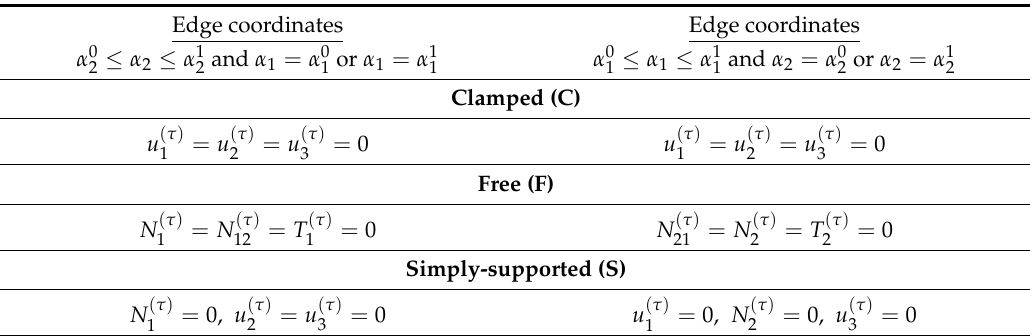
Table 1. Boundary conditions for the ESL model ( τ = 0,1,2, . . . , N , N + 1). Edge